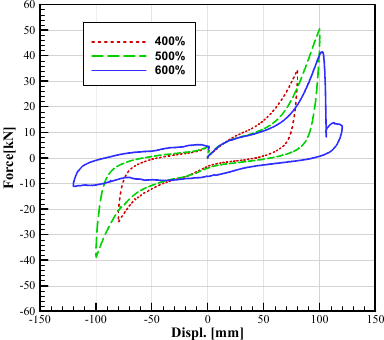
Figure 5. Hysteresis curve for OPT2.